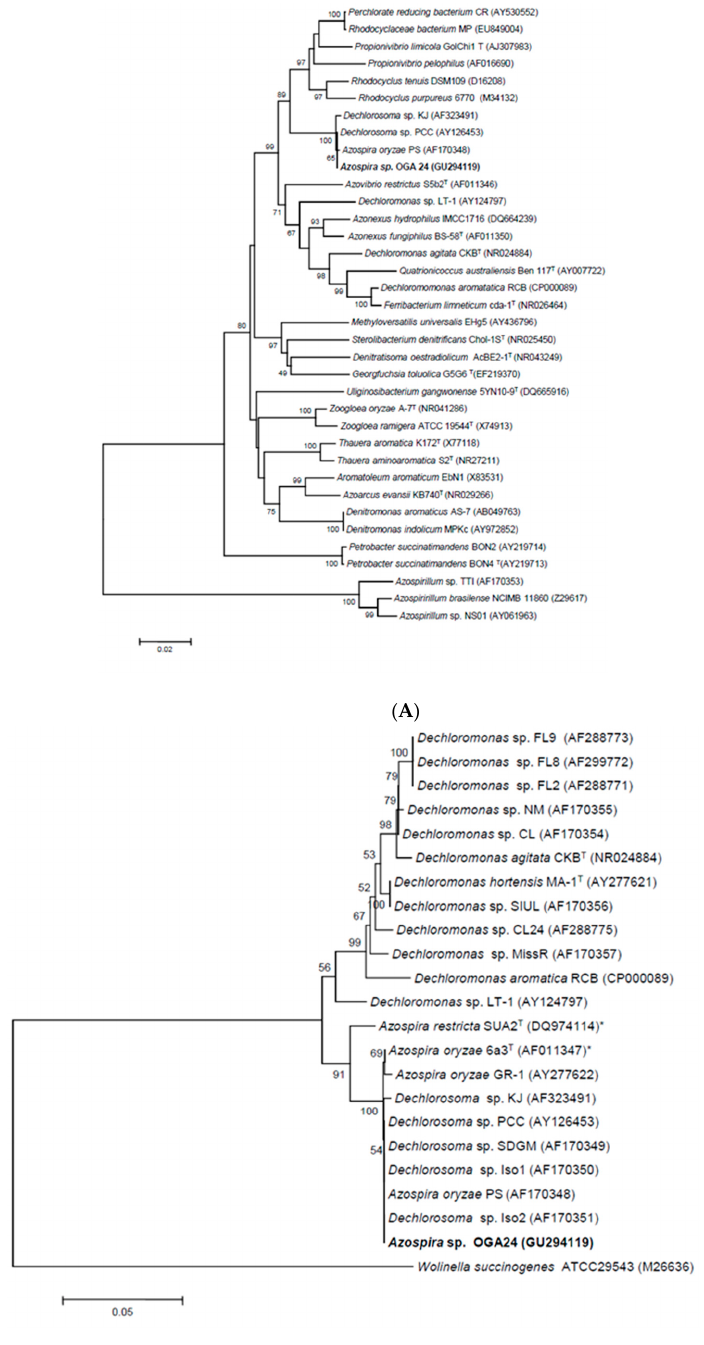
Figure 5. Phylogenetic analysis based on 16S rDNA sequences. Relationship of OGA 24 strain with Rodociclacea family of β - Proteobacteria ( A ) and with Azopira oryzae species ( B ). For the analysis, only nearly complete sequence (>1300 pb) were considered. In bold Azospira sp. OGA 24, in brackets GenBank accession numbers of the sequences. In ( B ) asterisk indicate species not perchlorate reducing. Wolinella succinogenes ATCC 29543 ( ε - Proteobaterium ) was introduced as an example of unrelated PRB proteobacterium. Bootstrap values (expressed as percentages of 1000 replications) >50 are shown at branching points.